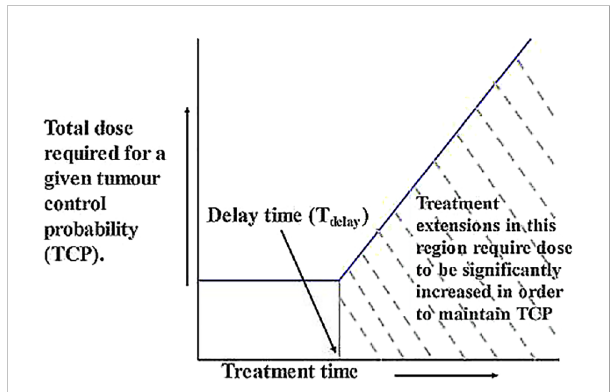
FIGURE 1 Graphical representation of the relationship between TCP and treatment duration. After the start of treatment, tumor repopulation remains close to zero, meaning that the dose required to maintain TCP remains essentially constant (horizontal line). After a delay of several weeks, the remaining cells begin to repopulate rapidly, and the additional dose required to kill new cells and maintain TCP increases linearly with time